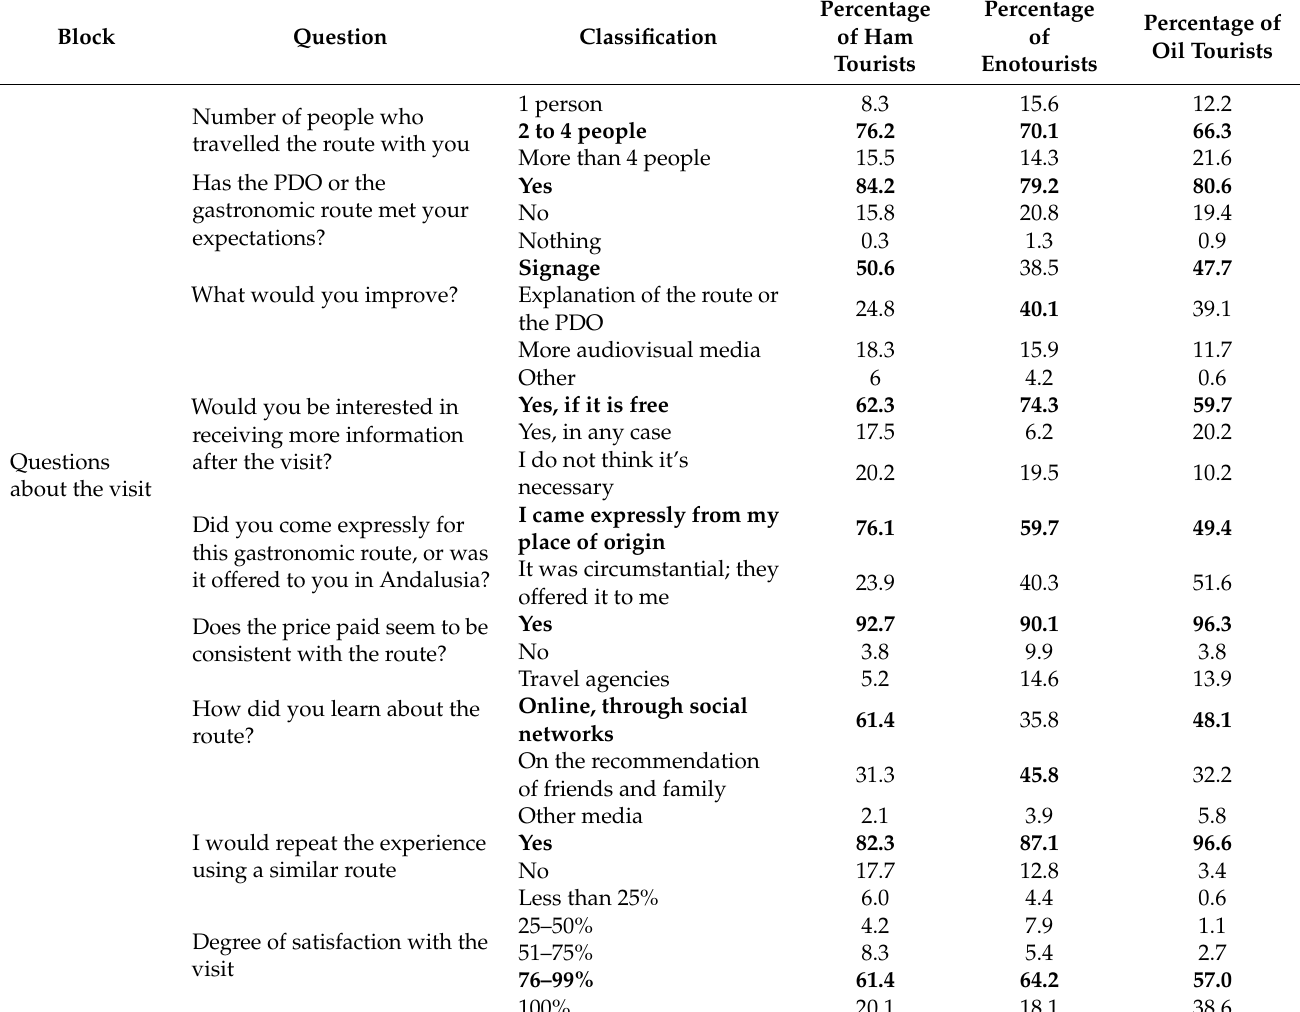
Table 4. Univariate results of the survey of gastronomic tourism on Andalusia: questions about the